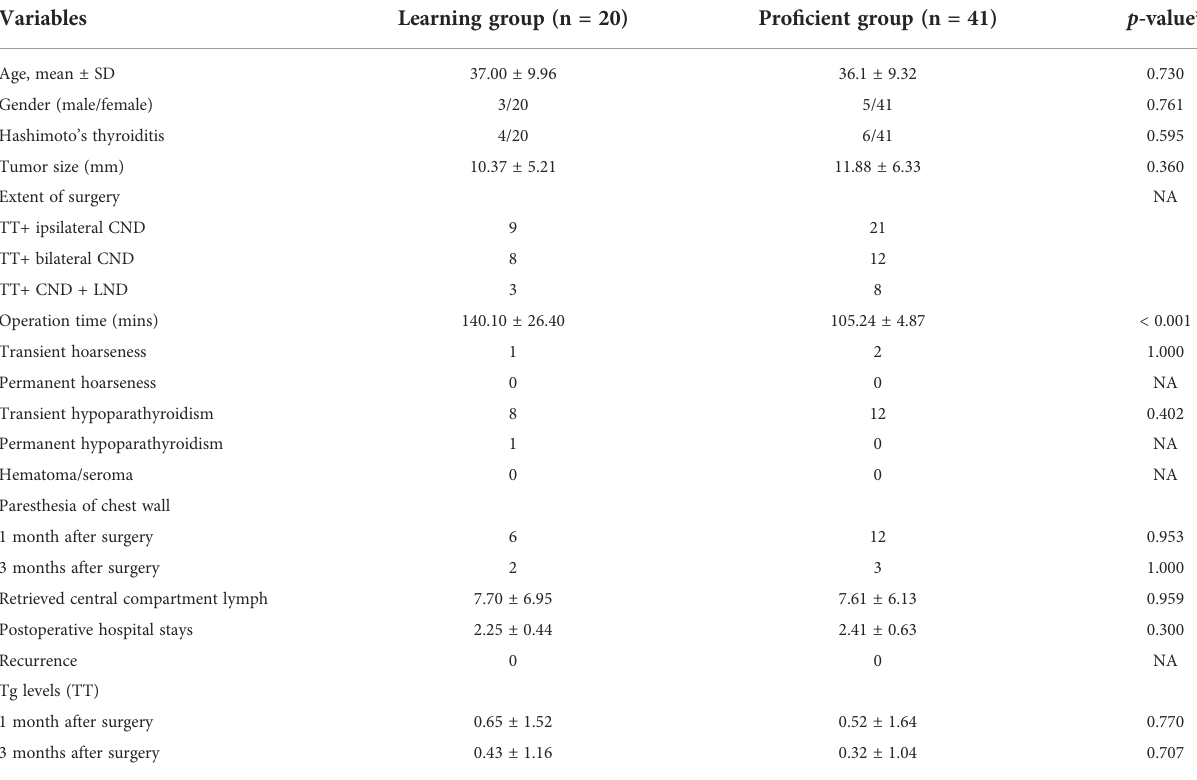
TABLE 2 Demographic data and surgical outcomes between learning group and the pro fi cient group under total thyroidectomy.